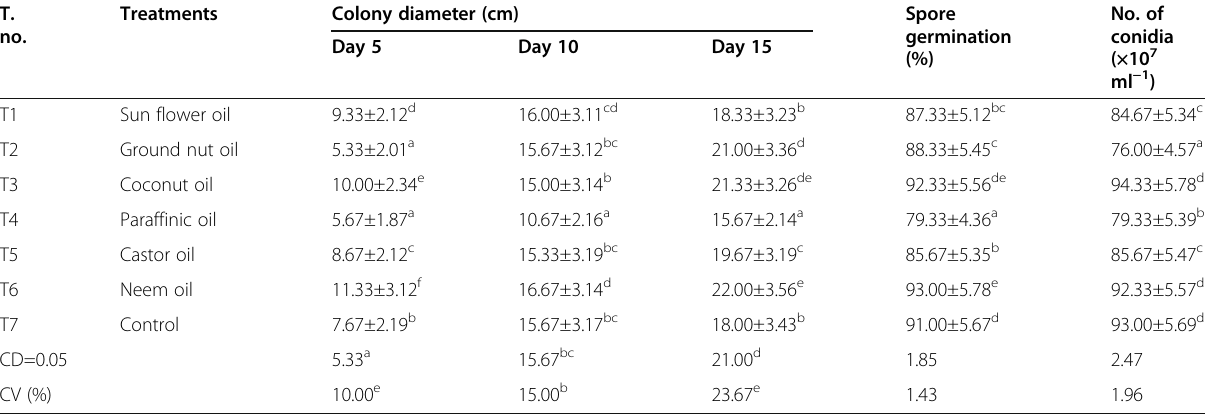
Table 6 Compatibility of different vegetable oils on the growth of Lecanicillium lecanii T.